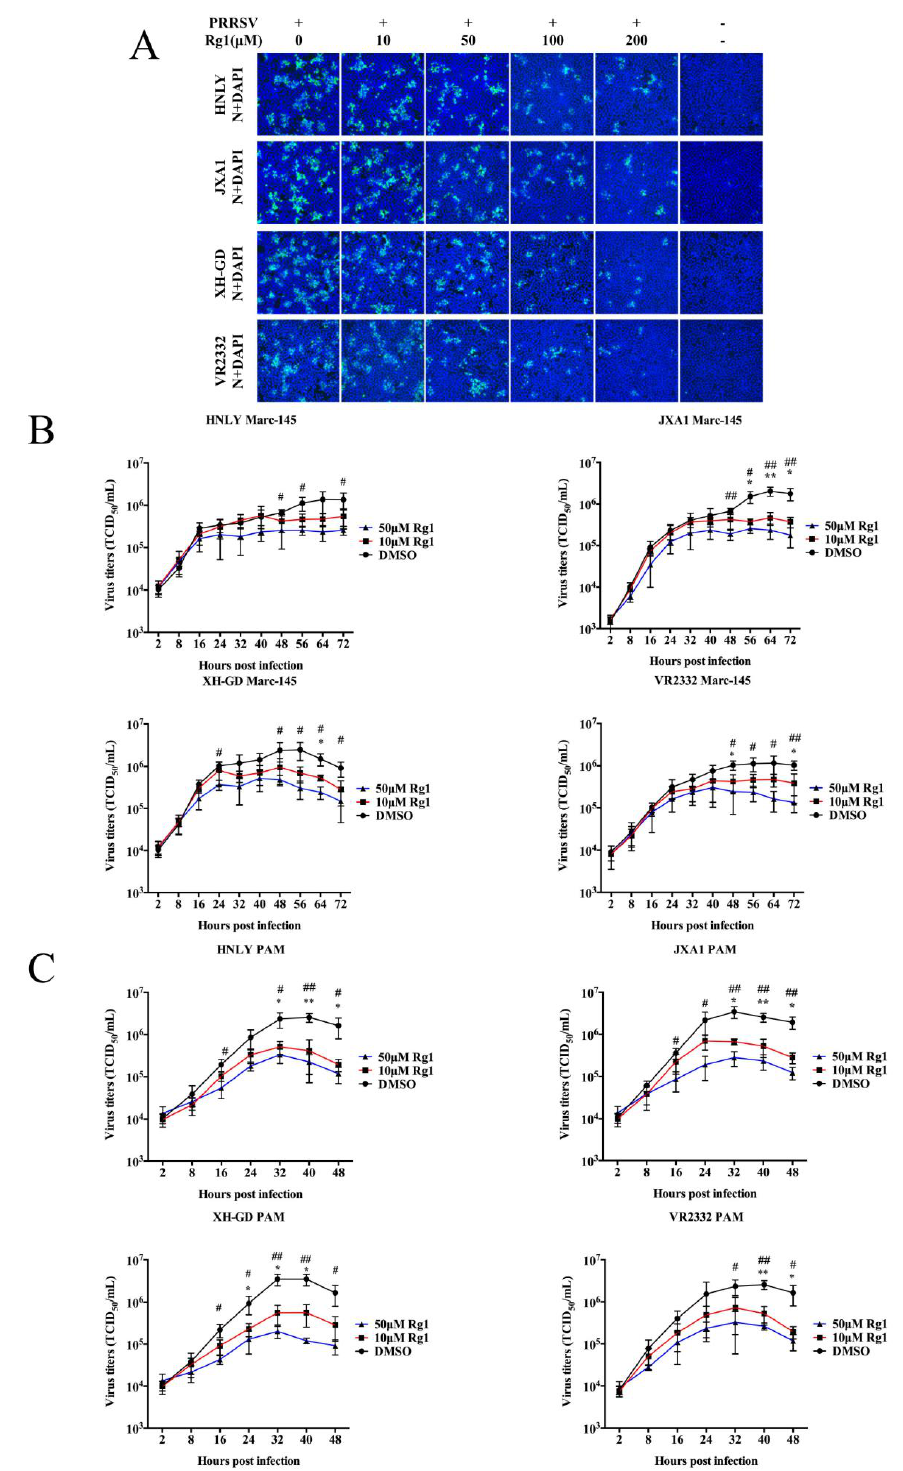
Figure 3. The antiviral activity of Rg1 against different lineages of type 2 PRRSV. ( A ) Antiviral activity of Rg1 against PRRSV strains (HP-PRRSV XH-GD and JXA1, classical VR2332 and NADC30-like strain HNLY) was determined in Marc-145 cells by IFA. Marc-145 cells were seeded in 12-well plates and infected with four type 2 PRRSV strain (0.1 MOI) respectively, and then incubated with DMEM supplemented with indicated concentration of Rg1. N protein was used as indicator of PRRSV infection, and the IFA detection of it was performed at 48 h.p.i. by using mouse anti-N protein antibody and goat anti-mouse IgG Alexa Fluor. Nuclei were counterstained with DAPI (blue). These images